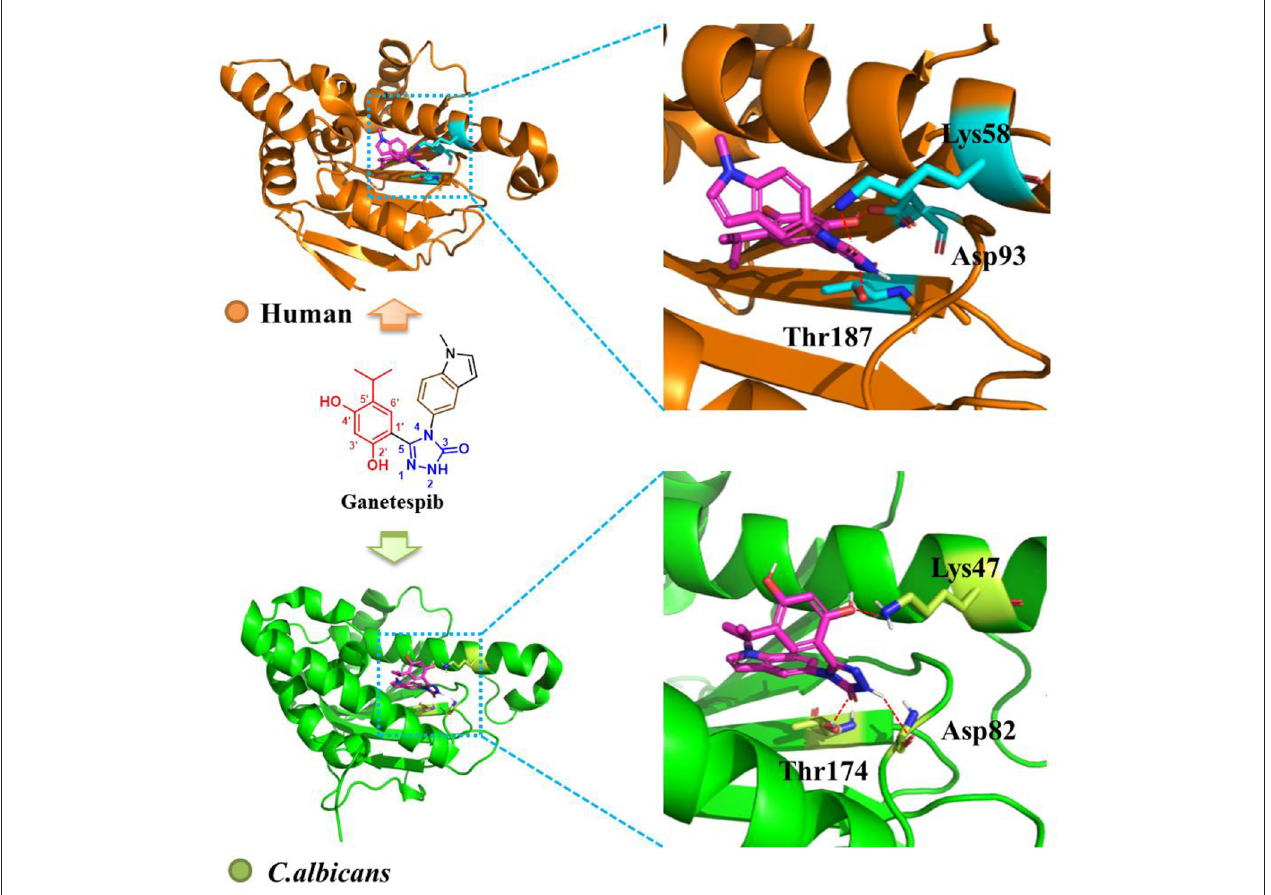
FIGURE 2 | Binding mode of ganetespib with human Hsp90 (orange, PDB code: 3UTH) and C. albicans Hsp90 (green, PDB code: 6CJS). The carbons of ganetespib are colored in magenta, nitrogen atoms in blue, and oxygen atoms in red. Red dashed lines represent the hydrogen bonding interactions. The figure was generated using PyMol